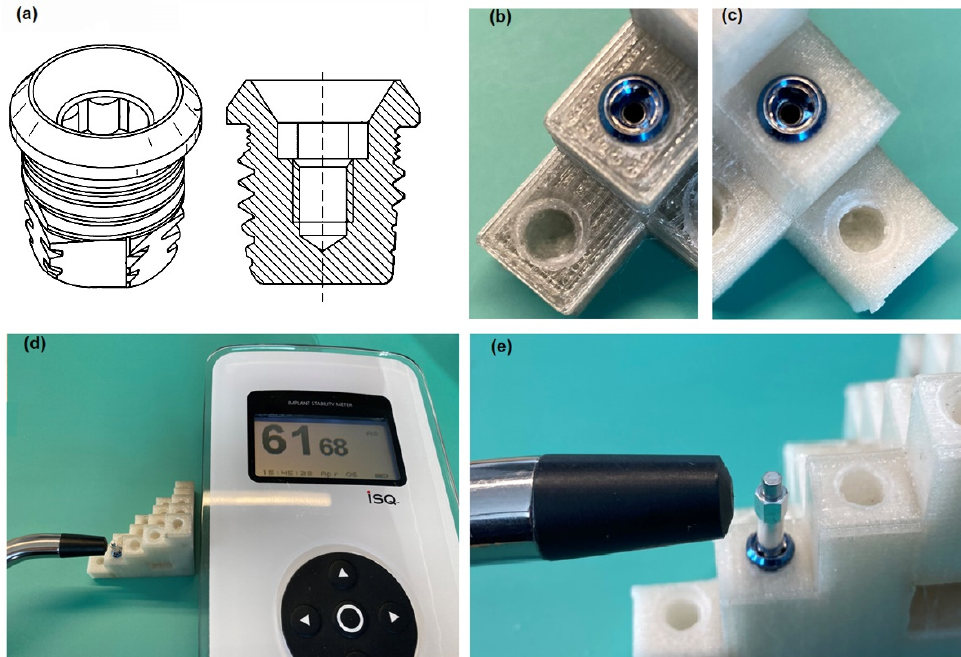
Figure 5. ( a ) Self-tapping VXI300 implant and VXI300 implant cross-section, where a characteristic thread can be seen [11]. ( b ) VXI300 implant mounted in a dry model (700 g PC/5 g PO/3.5 g talc). ( c ) VXI300 Implant mounted in an undried model (700 g PC/5 g PO/3.5 g talc). ( d ) Measurement system: Ostelle ISQ provided by Osstell with a magnetic handpiece and SmertPeg type 30 embedded in Cochlear VI300 implant. ( e ) Magnification: VXI300 implant embedded in test material with SmartPeg type 30 temporarily inserted.